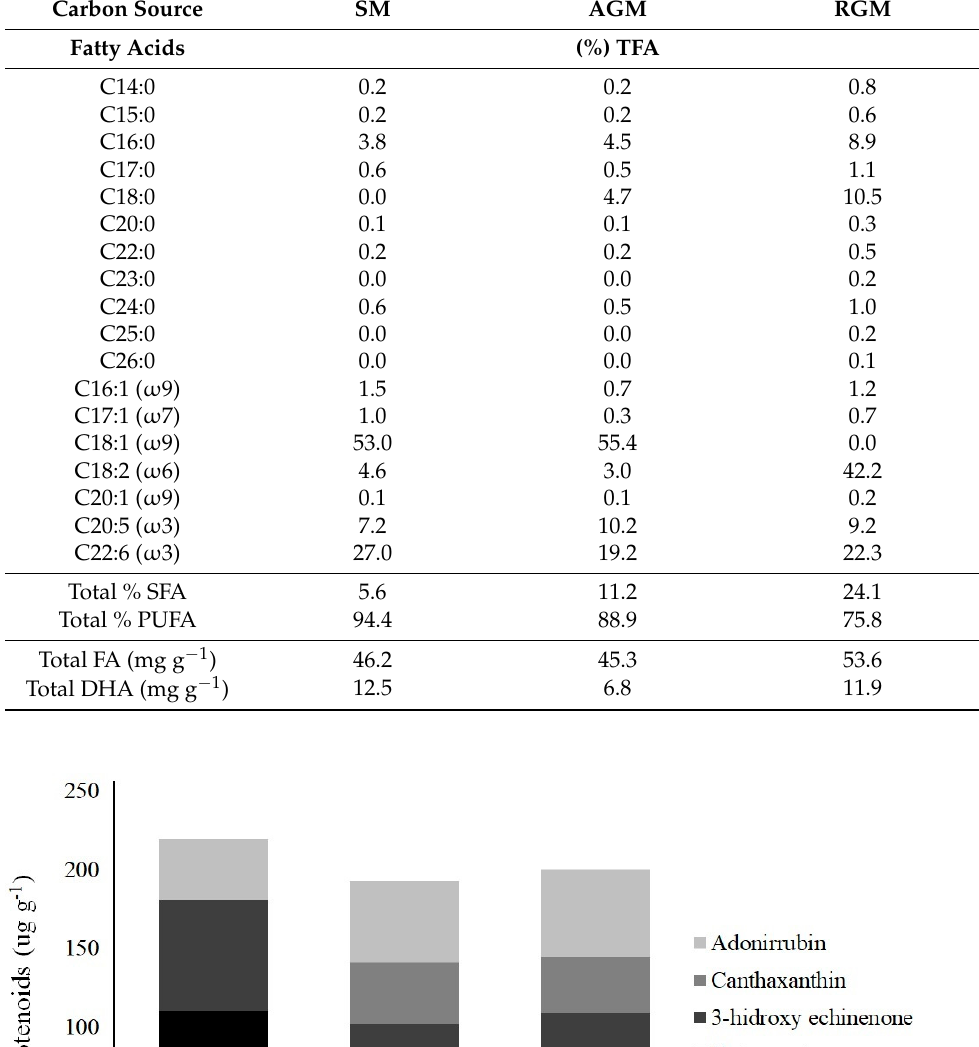
Table 2. Fatty acids profile from the NCYC 4007 strain cultivated in three different culture media at 15 ◦ C: Sabouraud medium (SM), media formulated with analytic grade glycerol (AGM) and raw glycerol (RGM). The results are shown as the percentage of total fatty acid (TFA). In addition, the amount of fatty acids (FA) and DHA are showed in mg g − 1 freeze-dried weight (FDW) biomass.